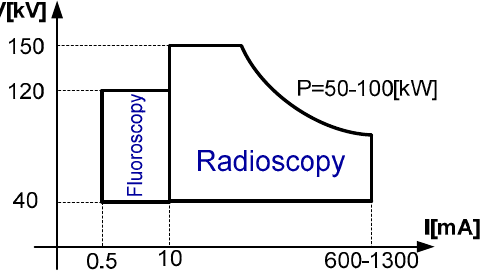
Figure 1. Output power and output voltage specifications for X-ray power supplies.